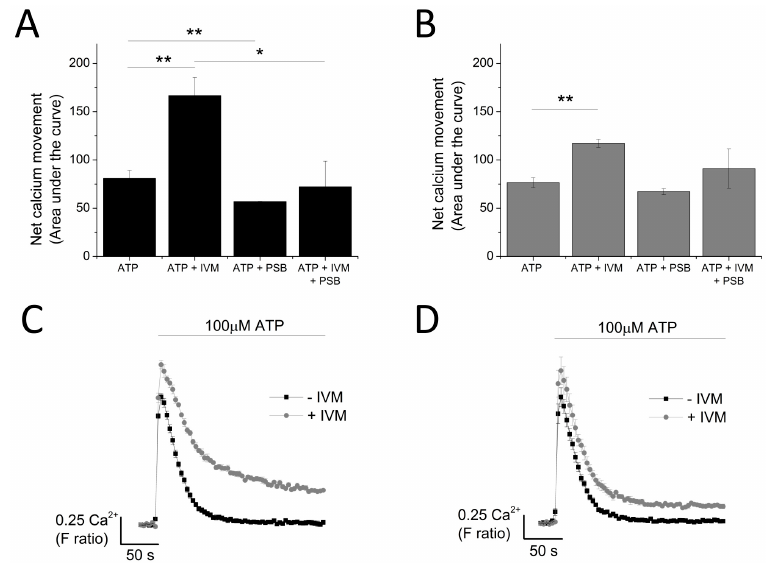
Figure 7. Knocking down P2X 4 reduced the sensitivity of THP-1 differentiated macrophages to IVM and PSB-12062. The effect of 10 µ M PSB-12062 on ATP response in the presence and absence of IVM in: ( A ) scrambled shRNA ( n = 4) vs. ( B ) P2X 4 shRNA ( n = 4). Representative time-response curves of the effect of IVM on ATP response in: ( C ) scrambled shRNA ( n = 4) vs. ( D ) P2X 4 shRNA ( n = 4). Asterisks include significant changes towards control (** p < 0.01, * p < 0.05).